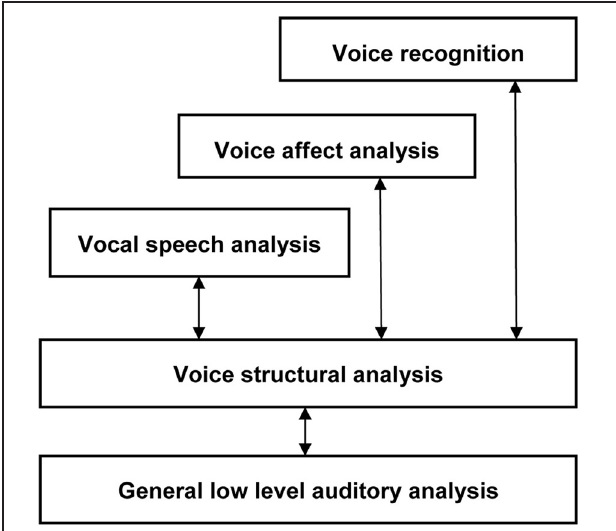
FIGURE 1 | The “auditory face” model of human voice perception, comprising separable functional pathways for processing speech, affect and identity information in voices [adapted from Belin et al.